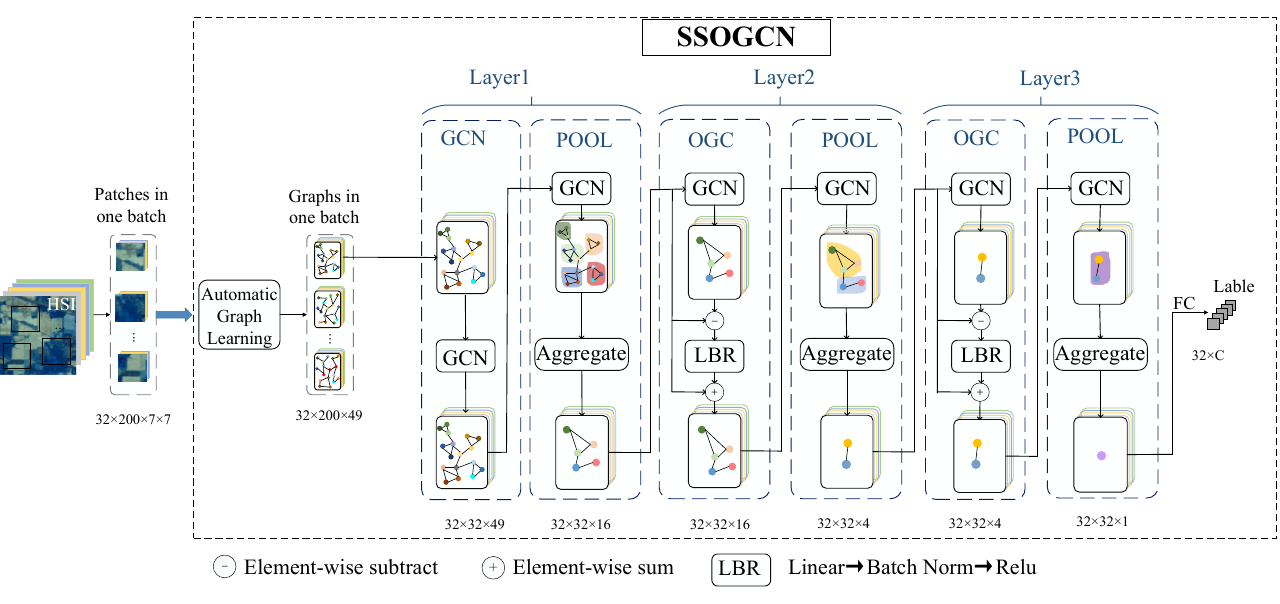
Figure 1. Framework of our SSOGCN.